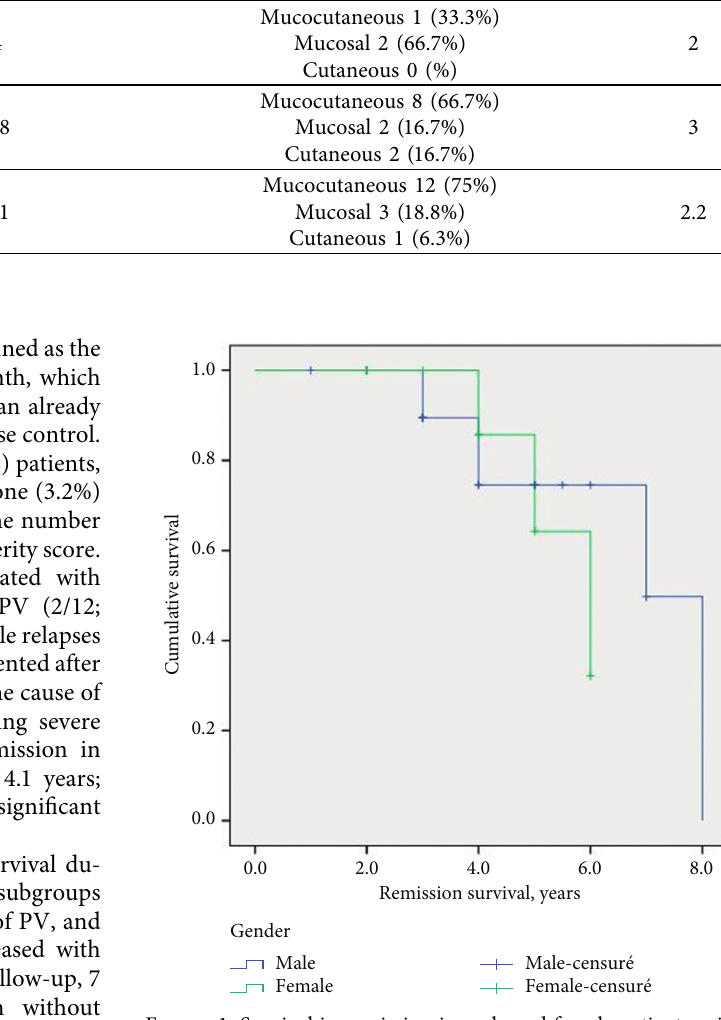
Figure 1: Survival in remission in male and female patients using Kaplan–Meier. Data are censored for patient deaths during the study